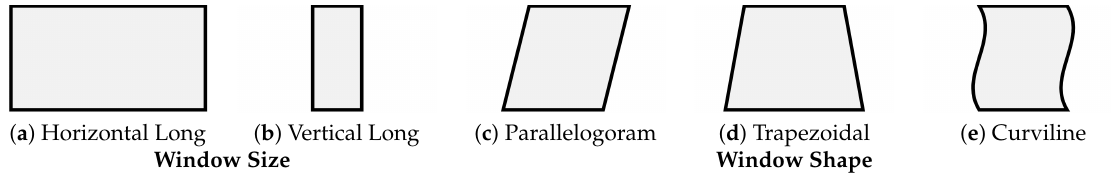
Figure 1. Examples of various kinds of window frames (horizontally long ( a ), vertically long ( b ), parallelogram ( c ), trapezoidal ( d ), and curvilinear ( e ). Horizontally-long and vertically-long being related to window size, and parallelogram, trapezoidal, and curvilinear belonging to the window